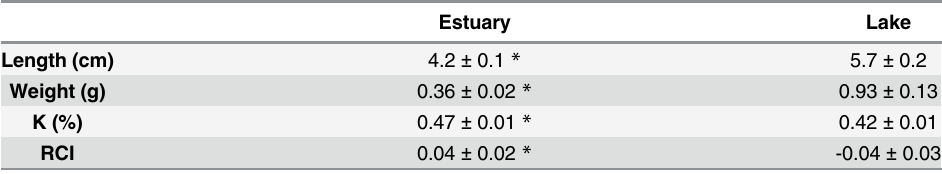
Table 2. Length, weight, Fulton´s condition factor (K) and residuals condition index (RCI):of two dif- ferent populations (estuary and lake) of juvenile G . maculatus submitted to different experimental salinities. Values are mean ± SEM (N = 31 –